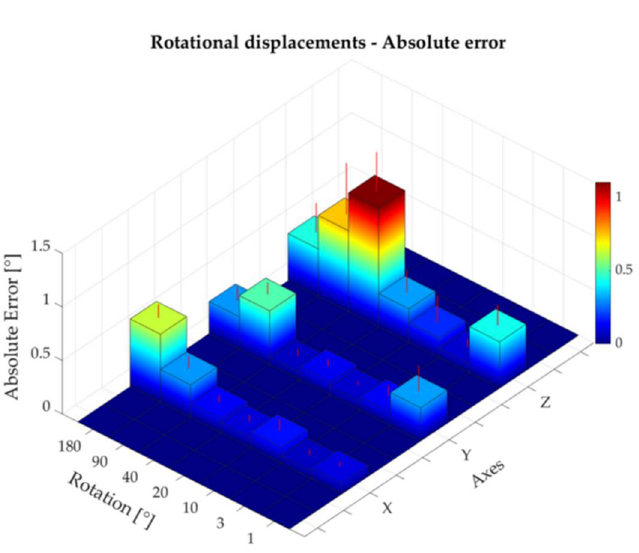
Figure 9. Absolute error corresponding to rotational displacements around the x-, y-, and z-axes.